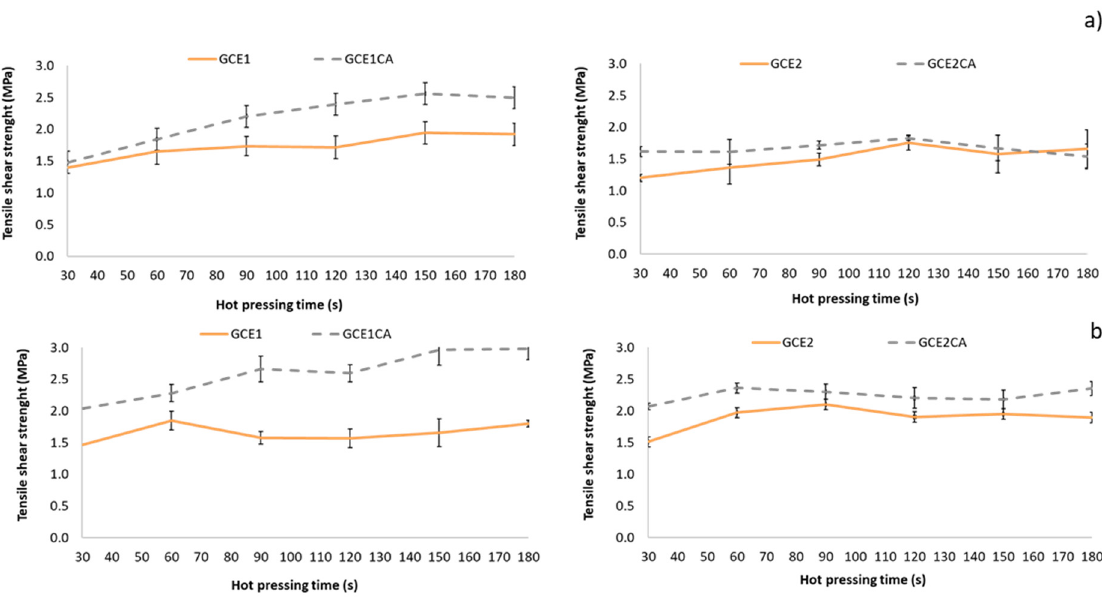
Figure 11. Development of shear strength as a function of hot-pressing time of GC E1 and GC E2 solutions alone and with citric acid (33 (% on adhesive weight, dry basis)) at ( a ) 120 ◦ C and ( b ) 160 ◦ C.